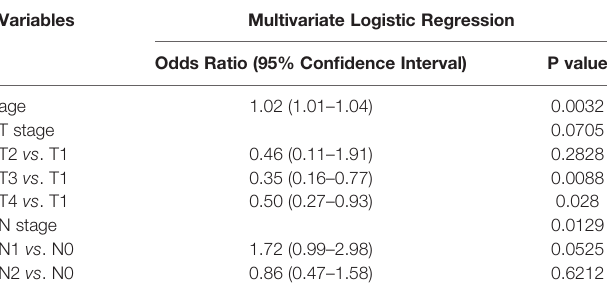
TABLE 2 | Multivariate Logistic Regression for clustering (Cluster 2 vs . Cluster 1).